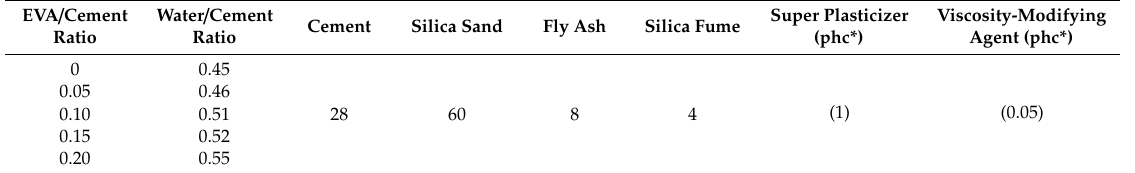
Table 8. Mix proportion for the EVA-modified mortars